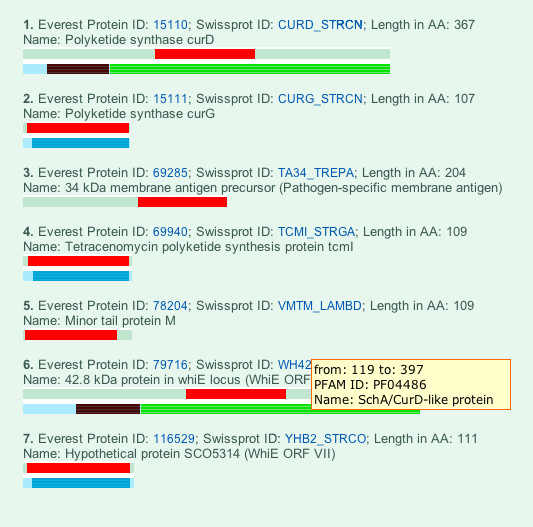
EVEREST family EV01.01017. Excerpt from the EVEREST web page for [EVEREST:EV01.01017]. Seven representative proteins (out of eight) containing domains of [EVERERST:EV01.01017] are illustrated. Red segments illustrate [EVEREST:EV01.01017] domains, green segments illustrate [Pfam:PF04486] domains, blue segments illustrate [Pfam:PF04673] domains and brown segments illustrate [Pfam:PF03992] domains. For details of this example see Functional annotation for a family with unknown function in section Examples: Selected EVEREST Families.